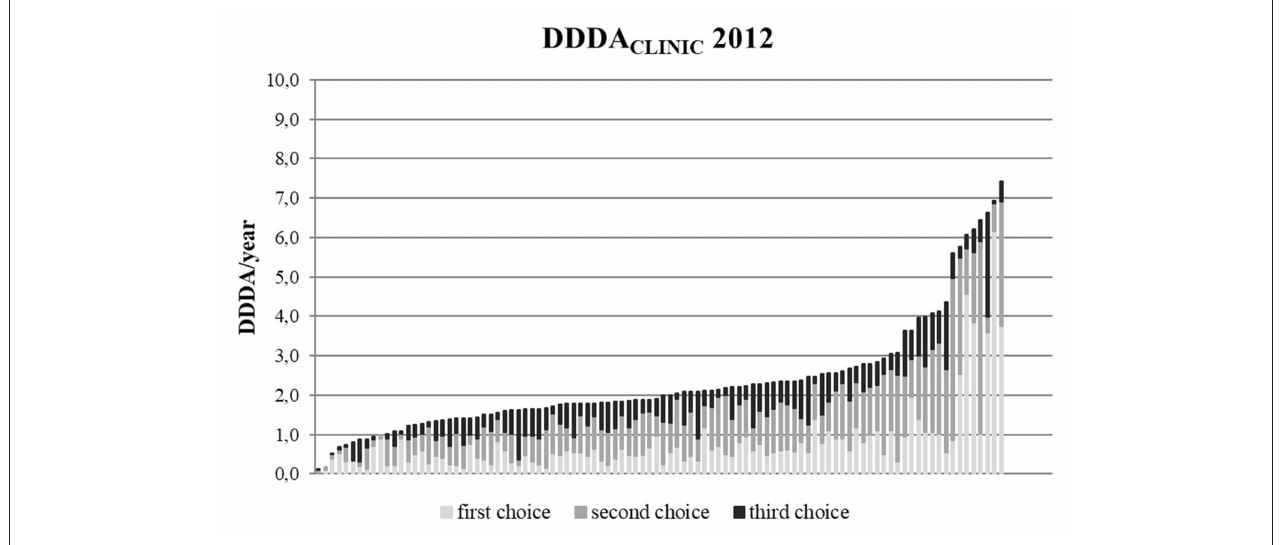
FIGURE 3 | DDDA CLINIC figures for all 100 clinics in 2012, specified for first, second, and third choice antimicrobials, showing the differences in AMU between clinics (based upon procurement data of these 100